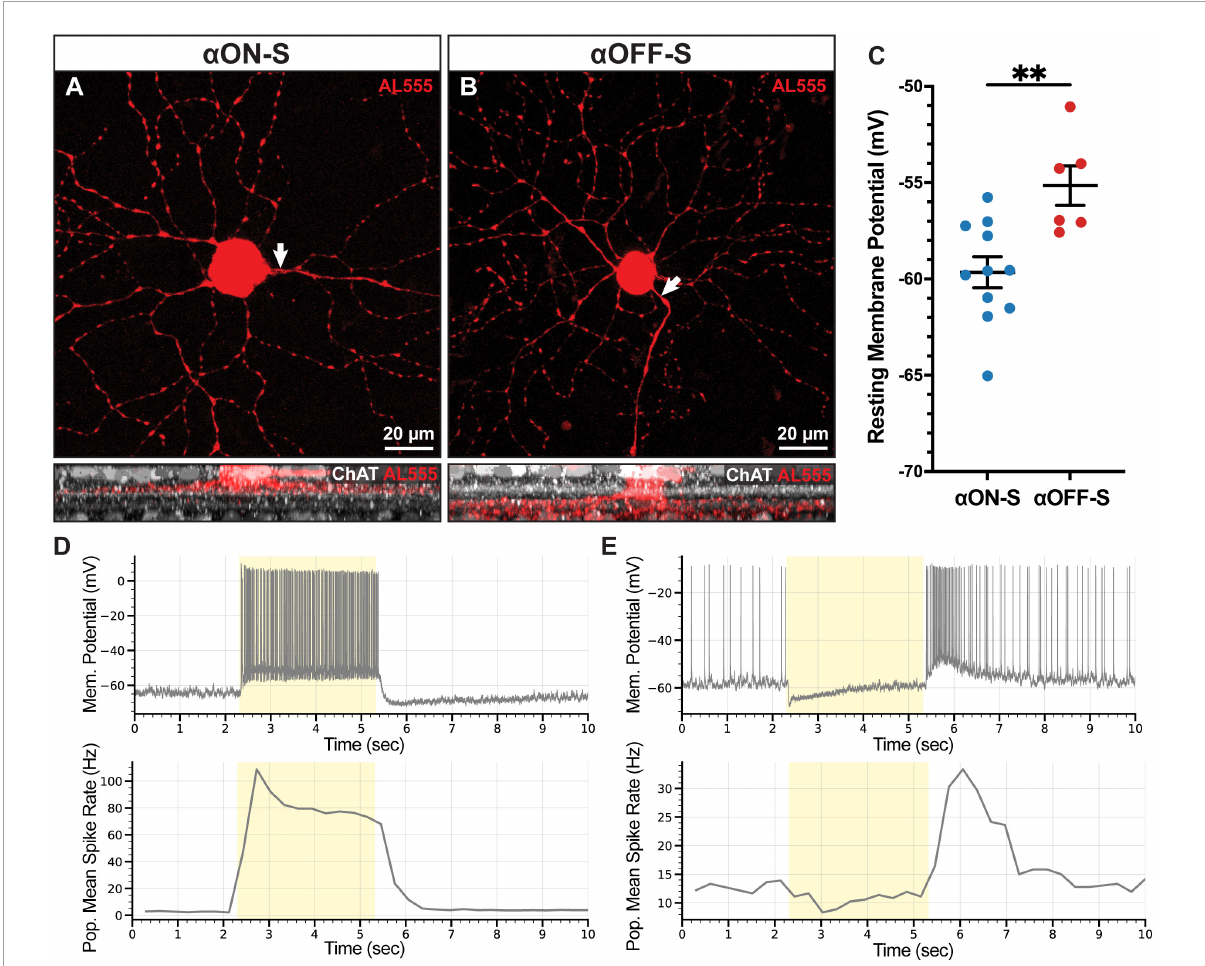
FIGURE1 Morphologic and physiologic characterization of retinal ganglion cells (RGCs). Patched cells were filled with Alexa-fluor 555 dye (AL555, red) and morphologically reconstructed with confocal microscopy. (A,B) Representative maximum intensity projections of alpha ON-sustained ( α ON-S) and alpha OFF-sustained ( α OFF-S) RGCs demonstrate characteristic soma size and dendritic branching patterns (upper). White arrows indicate the axonal projection. Orthogonal projections of representative AL555-filled cells co-labeled for choline acetyltransferase (ChAT, white) demonstrate the branching of α ON-S and α OFF-S dendrites in the ON- and OFF-sublaminas of the inner plexiform layer, respectively (lower). (C) α OFF-S RGCs have a more depolarized resting membrane potential (mean = –55.2 mV, n = 6) than α ON-S (mean = –59.7 mV, n = 11) ( p = 0.004, unpaired t -test). Error bars ± standard error of the mean. (D,E) Representative current-clamp traces of the responses of α ON-S (D, upper) and α OFF-S (E, upper) RGCs to full-field light stimulation (yellow span) show the characteristic light responses of the two cell types. Mean firing rates of all α ON-S (D, lower) ( n = 11) and α OFF-S (E, lower) ( n = 6) binned into 200 ms intervals during light stimulation (yellow). ∗∗ p <